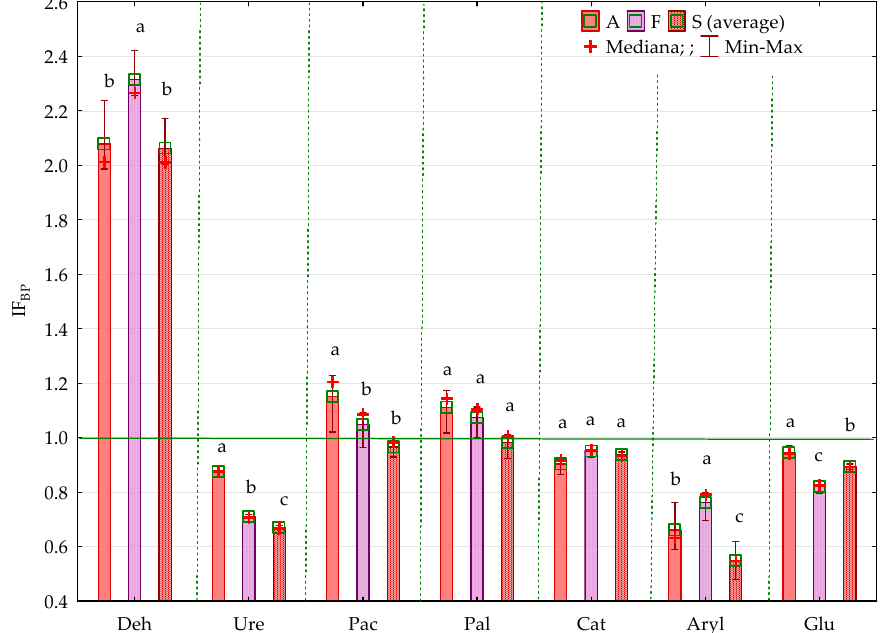
Figure 11. Coefficient of impact (IF BP ) of bisphenols for enzymes activity in soil contaminated with BPA, BPF and BPS in 15th day of research, A—soil contamination with BPA; F—soil contamination with BPF; S—soil contamination with BPS; Deh—dehydrogenases; Ure—urease, Pal—alkaline phosphatase, Pac—acid phosphatase, Aryl—arylsulphatase, Glu— β -glucosidase. Homogeneous groups denoted with letters (a–c) were calculated separately for each enzyme.